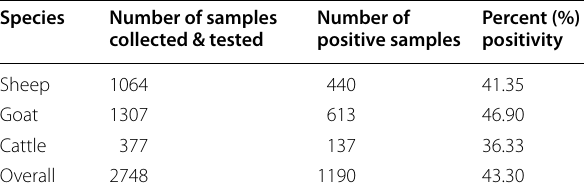
Table 1 Seroprevalence of anti-BTV antibodies among West Bengal